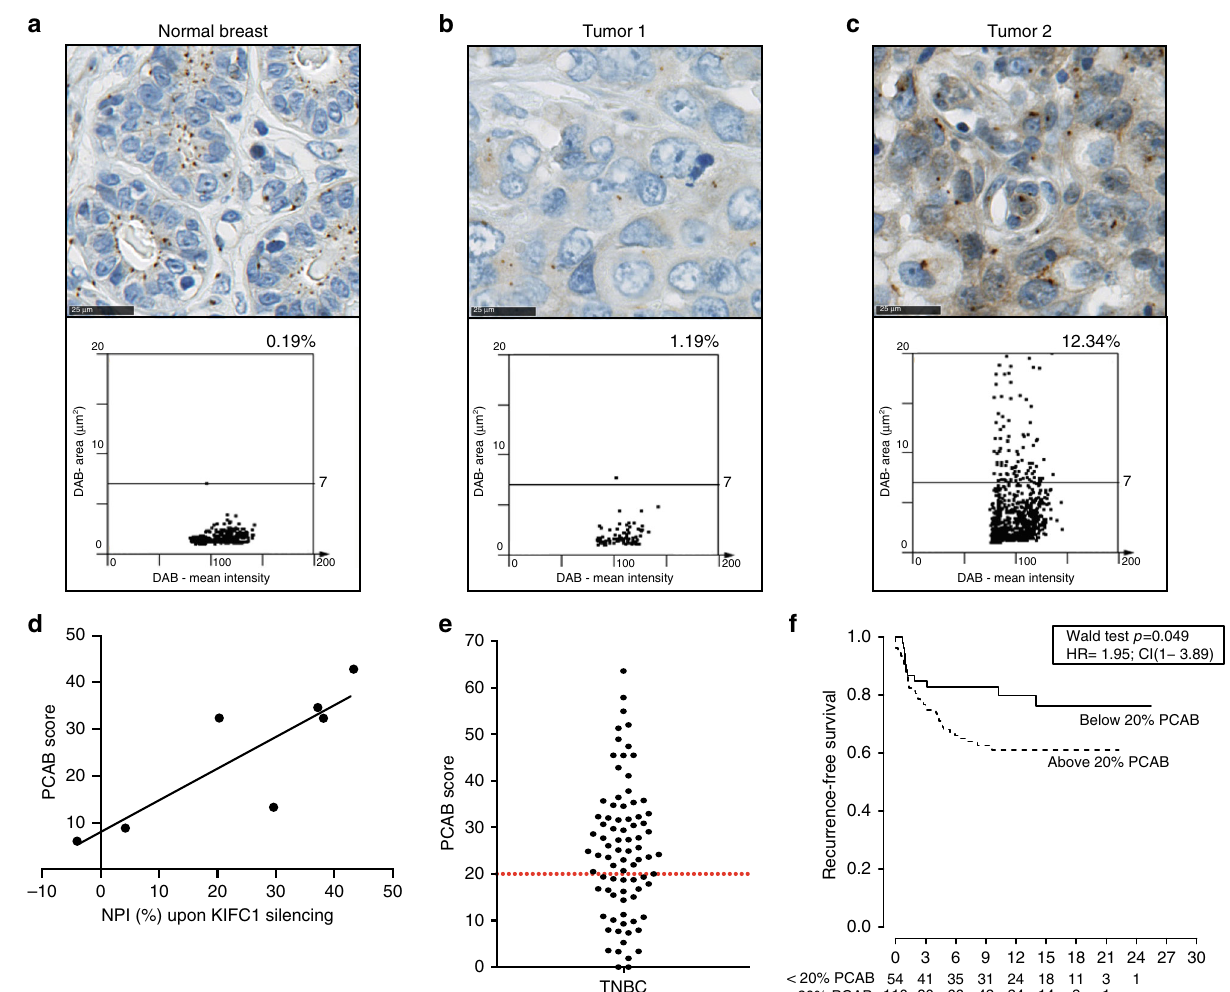
Fig. 7 Pericentrin abnormality score: a potential predictive biomarker for sensitivity to KIFC1 inhibition. a Normal breast tissue section stained for pericentrin as a centrosome marker and below, a scatter graph of DAB staining area versus DAB mean intensity. Cut-off for normal centrosome size was set at 7 µ m 2 . b Tumor 1 with centrosomes that appear normal. Below, scatter graph of DAB staining area vs DAB mean intensity showing a PCAB score of 1.19%. c Tumor 2 with centrosomes that appear abnormal. Below, scatter graph of DAB staining area vs DAB mean intensity showing a PCAB score of 12.34%. d PCAB score vs NPI (%) upon KIFC1 silencing across panel of breast cancer cell lines. Linear regression analysis, r 2 = 0.71, p < 0.05. Scale bars represent 25 μ m. e . PCAB score of TMAs of cohort of 82 TNBCs. Dashed red line depicts the median PCAB score (32%) of breast cancer cell lines sensitive to KIFC1. f Kaplan – Meier curves illustrating the duration of recurrence free survival according to a 20% PCAB cut-off. Wald test, p < 0.05, hazard ratio (HR) = 1.95, con fi dence intervals (CI) = 1 –